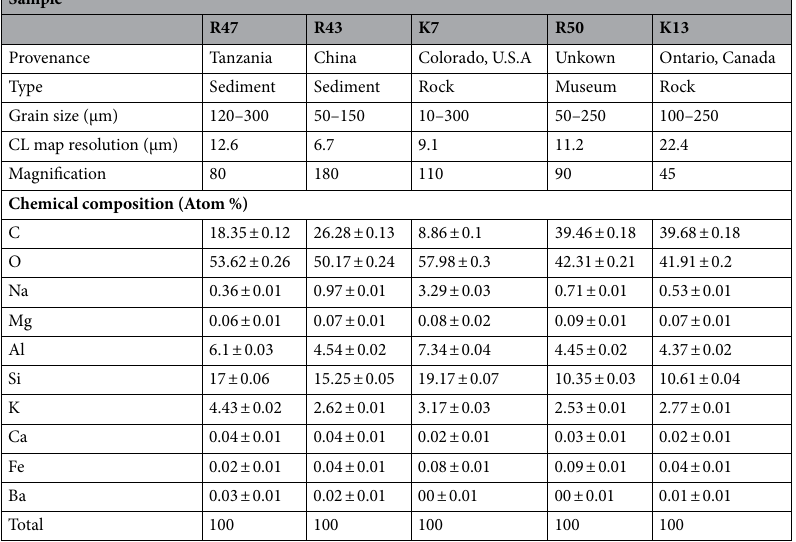
Table 1. Compositions for feldspar samples measured using energy-dispersive x-ray spectrometry (EDX); cumulative concentrations (from total mapping area) are given in atom %. Such a high concentration of carbon in feldspar is not possible, it is due to the carbon tape, which was used to hold the samples. Elemental mapping and quantification were done by probing the characteristic x-ray lines of the major elements. Samples R47, R43, and R50 are well characterized and studied previously by Prasad et al. 17 . Samples K7 and K13 are also well characterized and studied previously by Baril 49 , Baril and Huntley 50 , and Meisl and Huntley 51